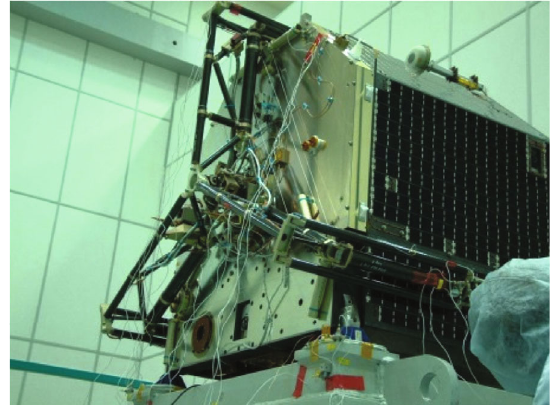
Figure 2: Rosetta probe.